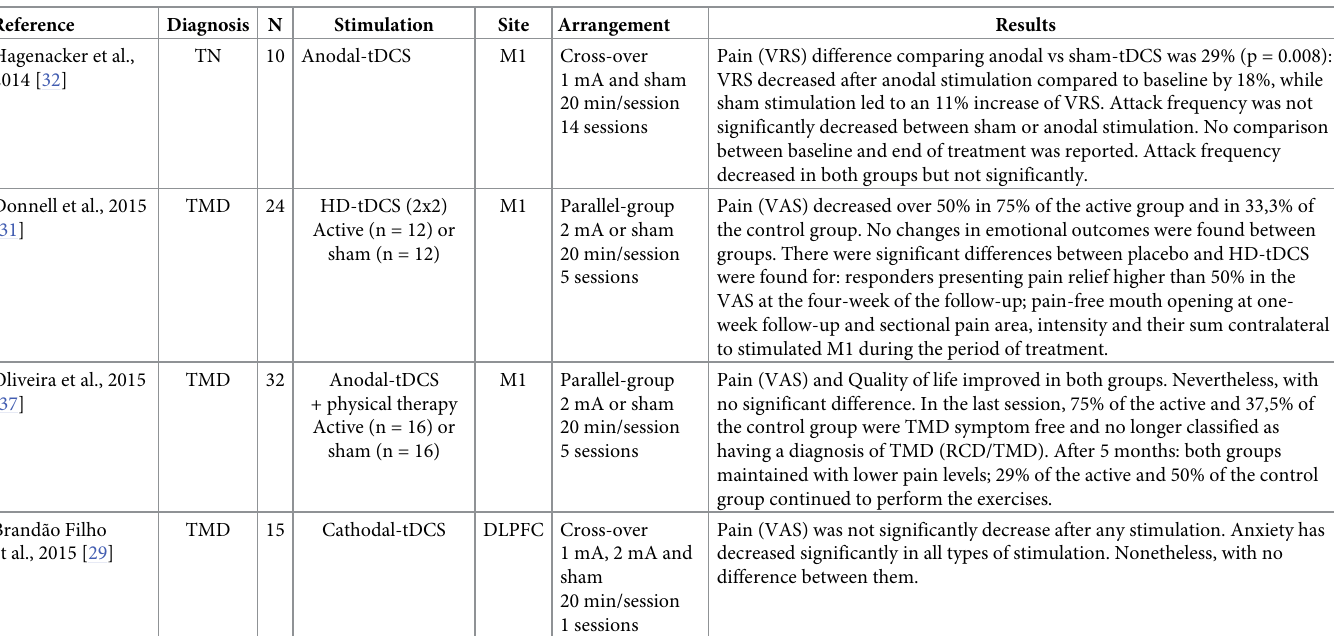
Table 3. Main findings of the tDCS